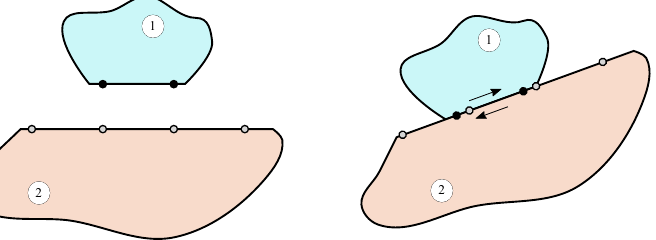
Figure 1. Schematic of contact problem in the substructuring framework. Left : Substructures 1 and 2. Right : Substructures 1 and 2 in relative